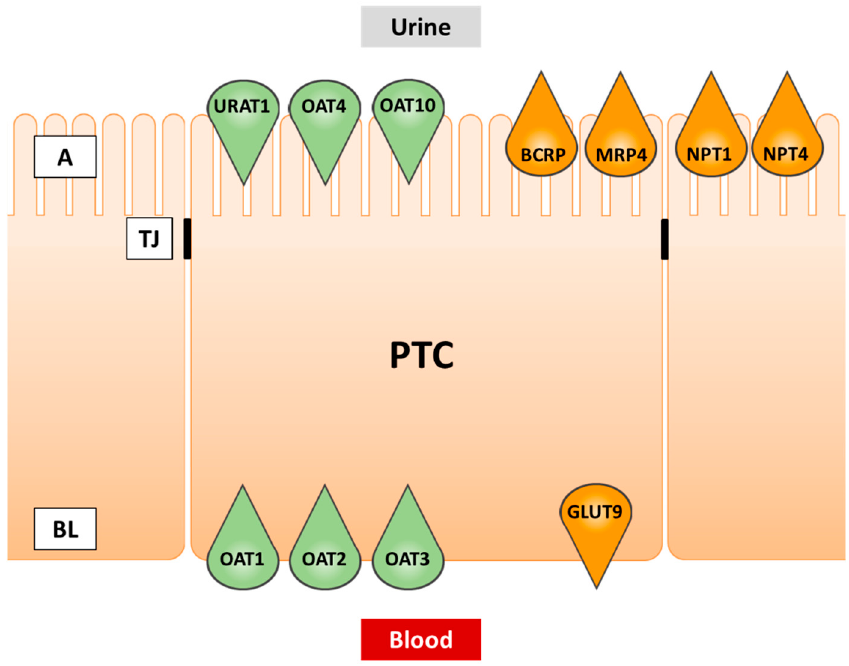
Figure 2. Transporters of urate in renal proximal tubule cells. Green fill color: transporters involved in cellular uptake. Orange fill color: transporters involved in cellular efflux. PTC, proximal tubule cell; A, apical (urine) side; BL, basolateral (blood) side; TJ, tight junction.